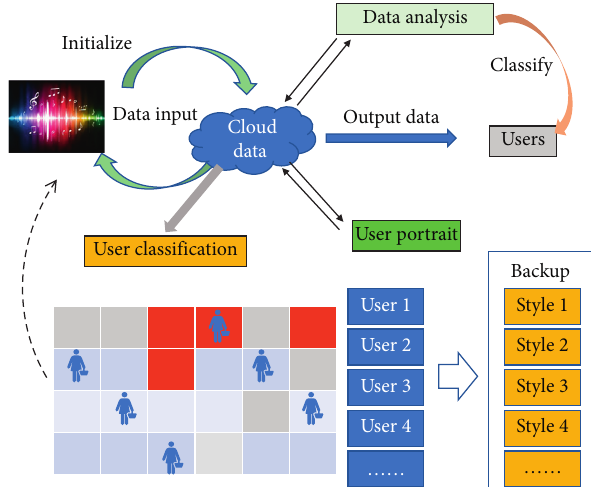
Figure 1: Particle swarm optimization strategy based on filtering